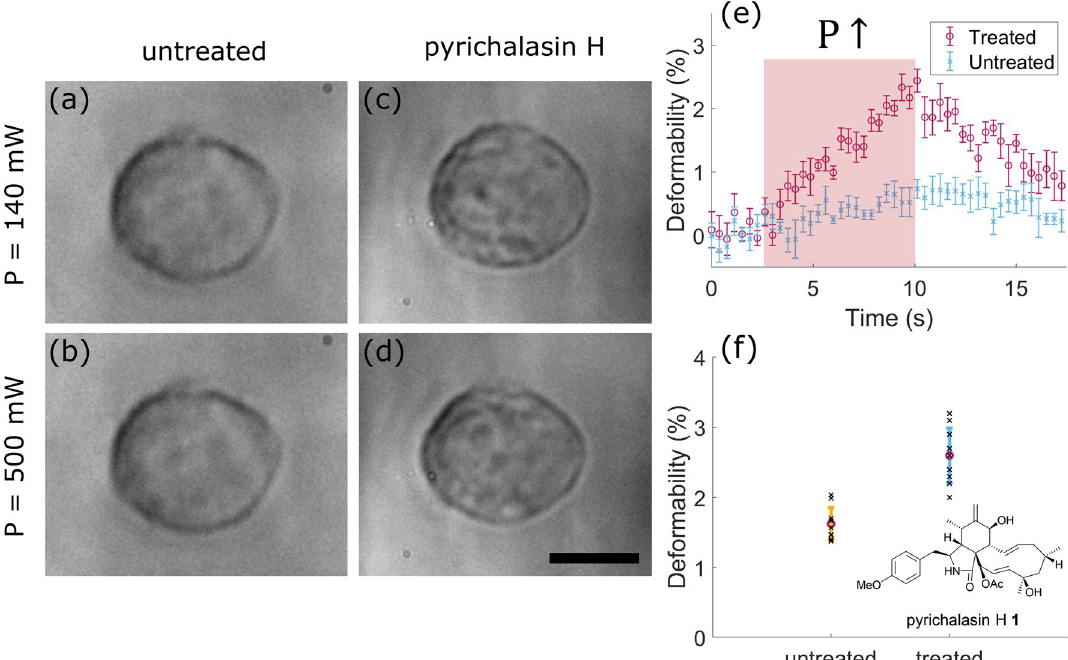
Figure 5. Example images of optical stretched breast cancer cells (MCF-7). The images in top row show untreated ( a ) and pyrichalasin H treated cells ( c ) at incident laser power ( P ) of 140 mW from each fiber. The bottom row shows untreated ( b ) and treated ( d ) cells at P = 500 mW from each fiber. The treated MCF-7 cells show larger deformation at higher incident laser power. Scale bar is 10 μm. ( e ) Comparison of the deformability of untreated and treated MCF-7 cells with pyrichalasin H over time (n=5 cells). Error bars indicate ± 1 standard error of the mean. The shaded area indicates when P is increased to 500 mW. High laser power (P = 500 mW) is applied for a fixed duration of 7 seconds. Afterwards, laser power is decreased to 140 mW. ( f ) Summary of the deformability for individual optically stretched cell. The average deformability is marked with a magenta circle (n=10 cells). Error bars correspond to ± 1 standard